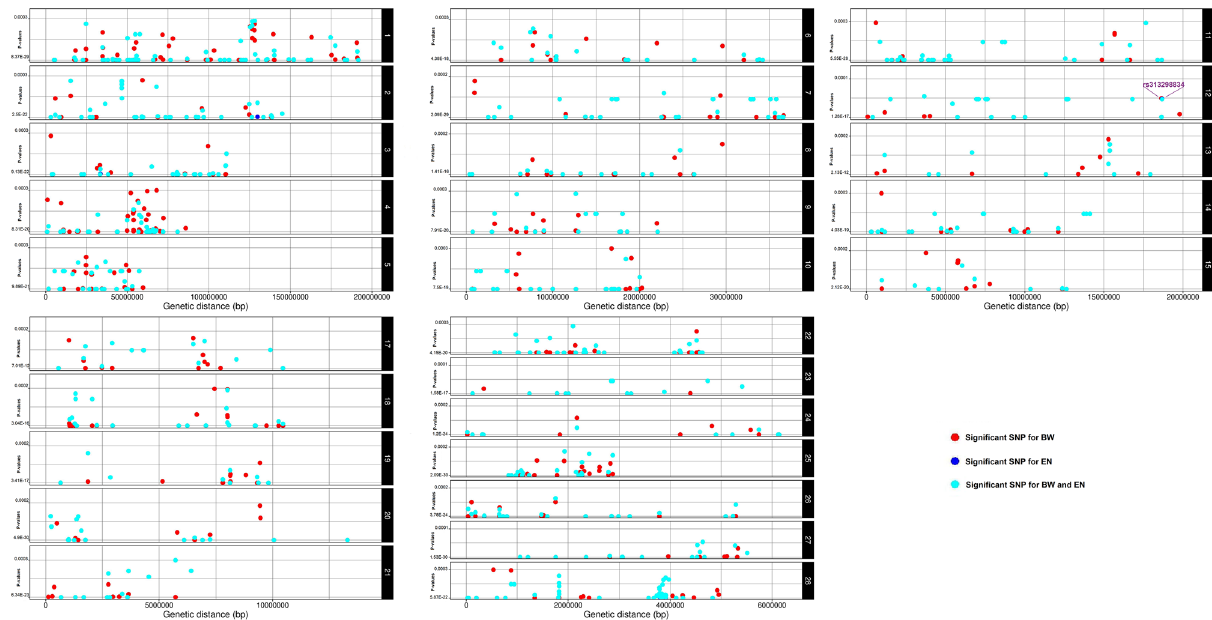
Figure 2. Graphic depiction showing the positions of the genome-wide significant SNPs (denoted as points) and their p values from univariate and bivariate analyses aligned along each autosome. Black labels with number denote the chromosomes. Each SNP position is linked to at least one colored circle representing the associated trait (s) (i.e. body weight (BW): red circle, egg number (EN): blue circle and both traits: cyan circle). The common SNP between the three analyses (2 univariate and 1 bivariate analyses) is presented with purple color. Plot was constructed using the shinyChromosome (https:// yimin gyu. shiny apps. io/ shiny Chrom osome 59 ).